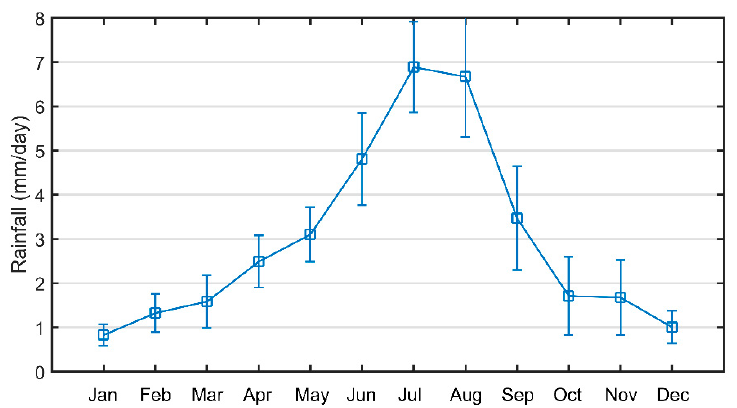
Figure 9. Average monthly rainfall in the area around the Yellow and Bohai Seas.